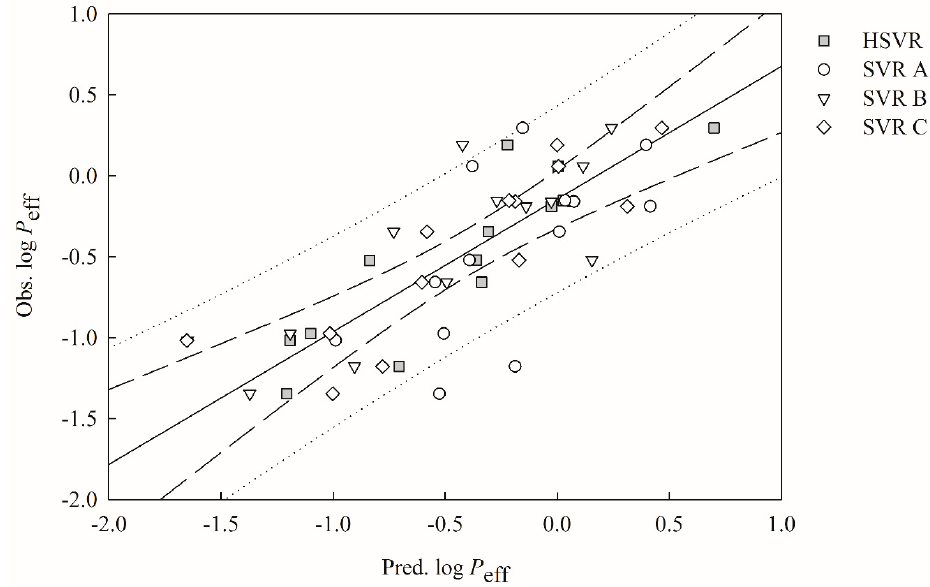
Figure 3. Observed log P eff vs. the log P eff predicted by SVR A (open circle), SVR B (open triangle), HSVR SVR C (open diamond), and HSVR (gray square) for the molecules in the test set. The solid line, dashed lines, and dotted lines correspond to the HSVR regression of the data, 95% confidence intervals for the HSVR regression, and 95% confidence interval for the prediction, respectively.